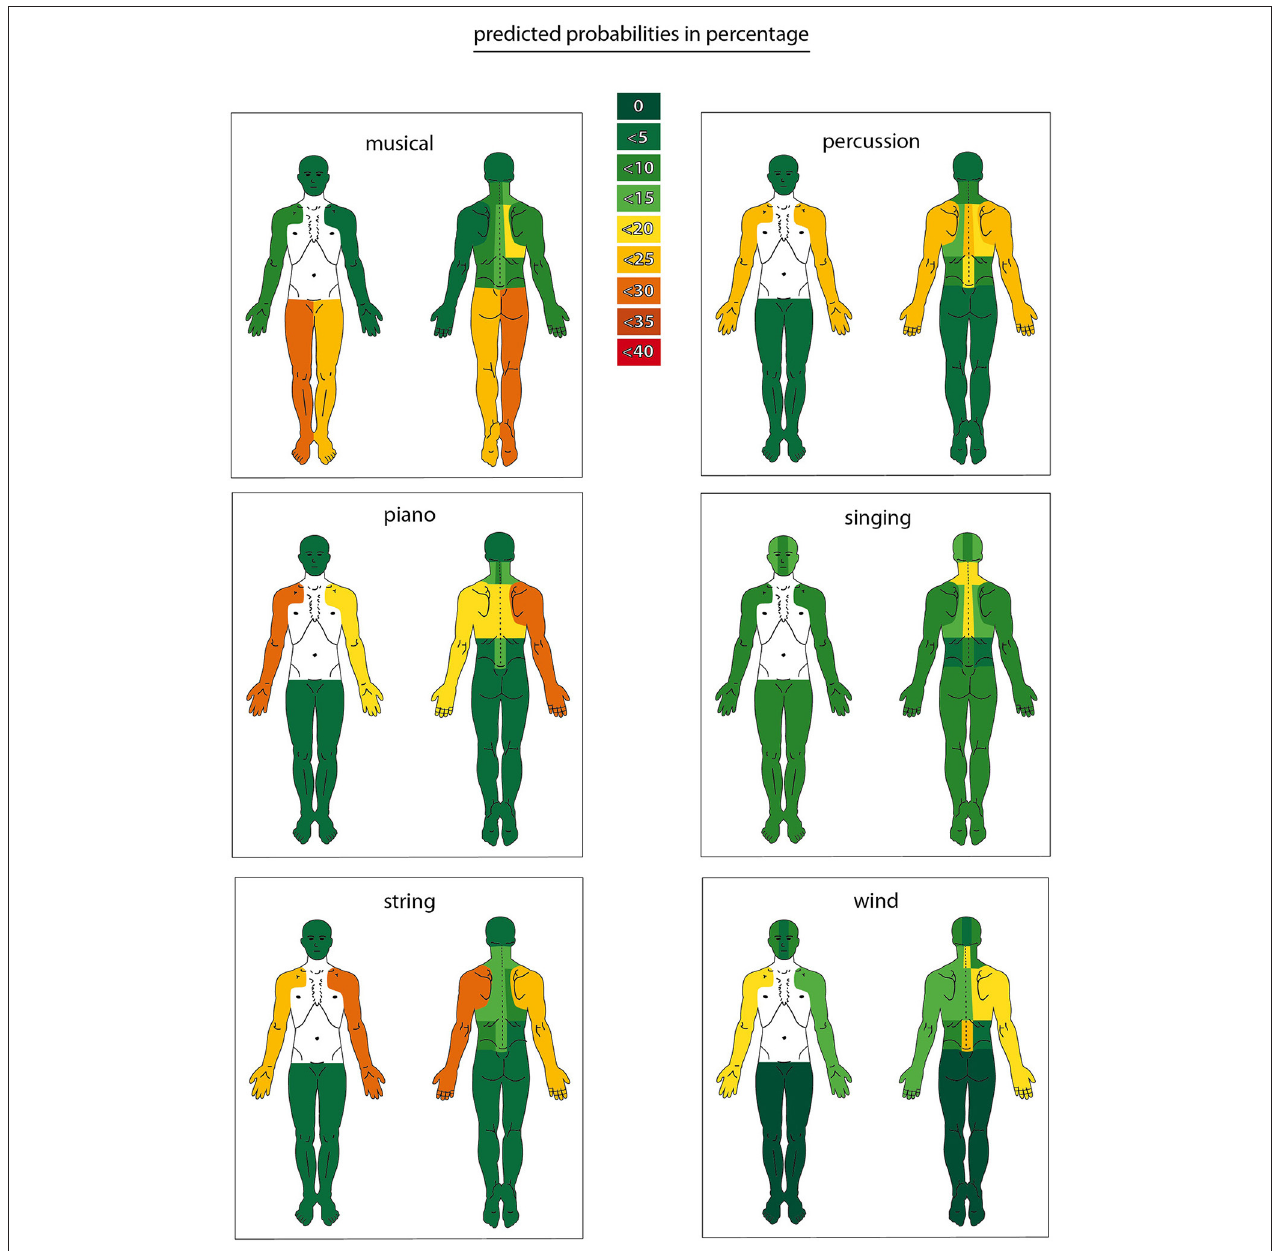
FIGURE 2 | Predicted probabilities for primary complaints in every